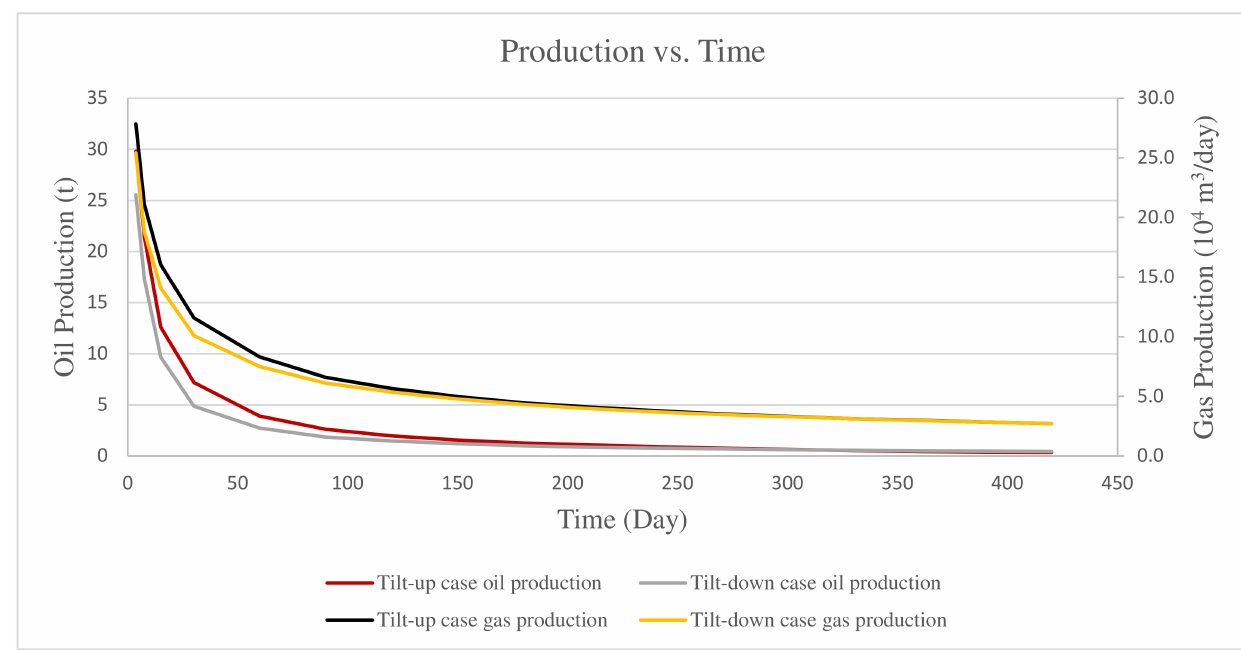
Figure 20. Comparison between two well examples with simulated production